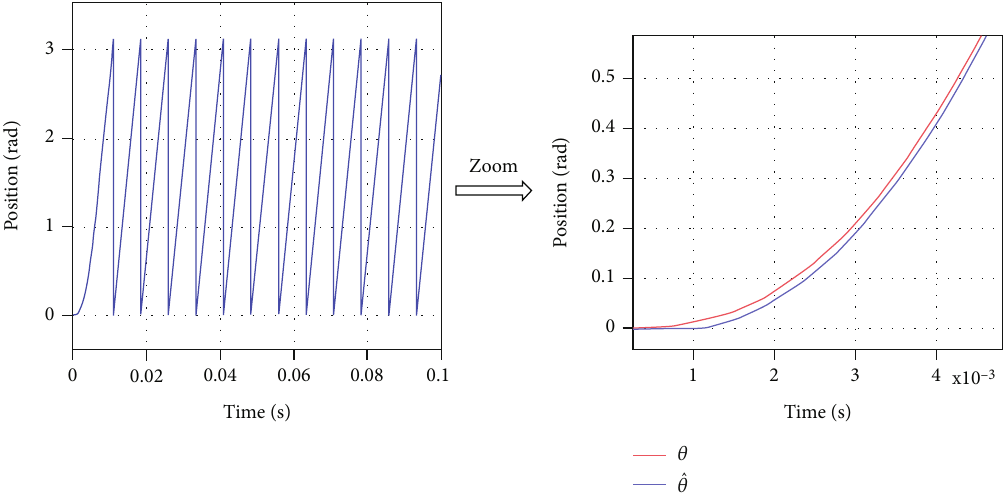
Figure 17: Results of estimated position using the proposed method.